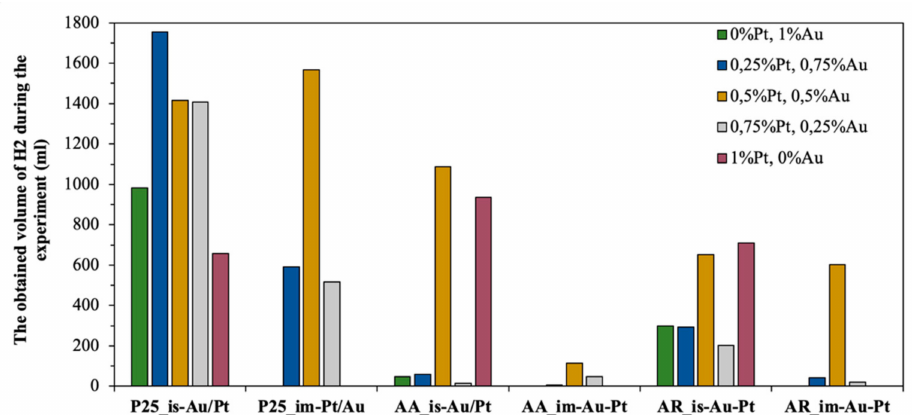
Figure 11. The obtained volume of H 2 in mL after the two-hour experiments.